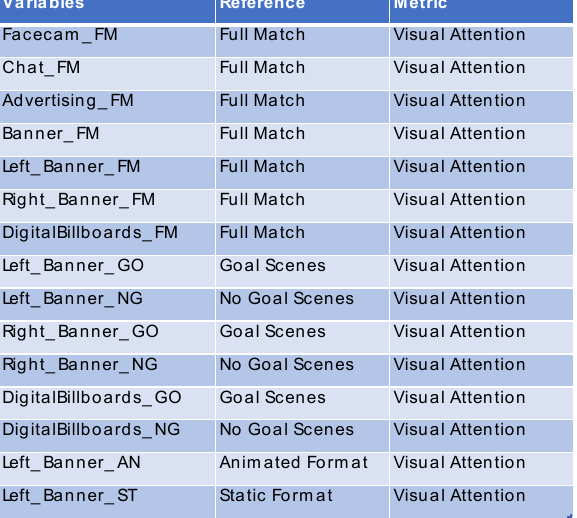
Figure A2. Variables selected for the study.